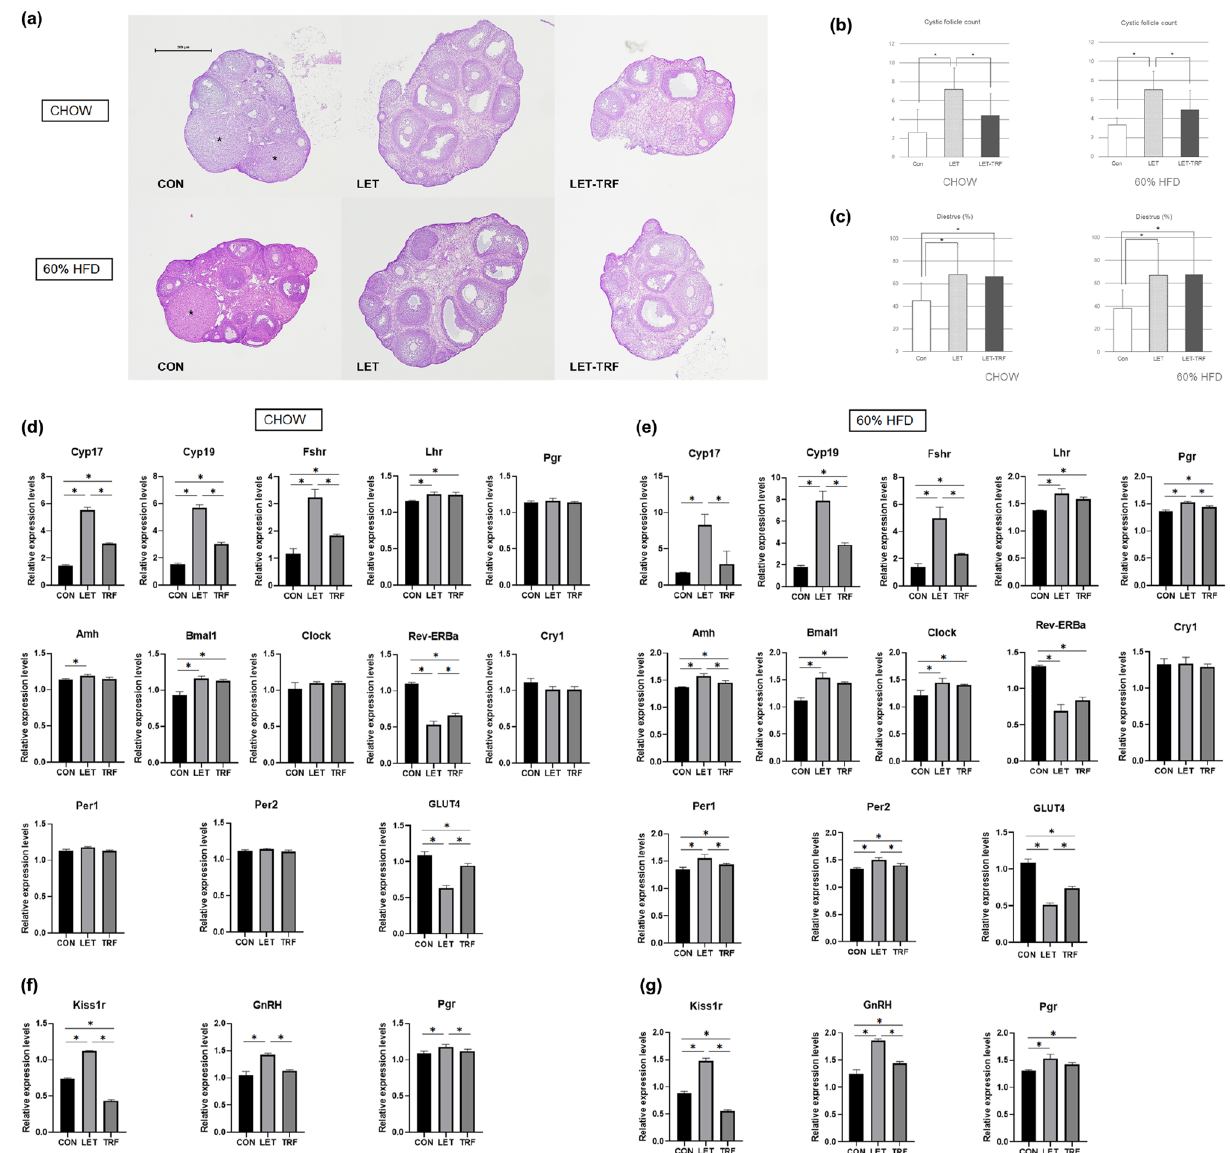
Figure 4. Histological findings of the ovaries, assessment of ovulatory disfunction, and the ovary/hypothalamus expression of key reproductive or circadian rhythm-associated genes. ( a ) Representative images of histological findings of ovaries with H&E staining from CON, LET, and LET-TRF mice according to diet. The ovaries of LET mice showed virtually enlarged and polycystic morphologies compared to those of CON and LET-TRF mice, either in CHOW or 60% HFD. Asterisks indicate the identified corpus luteal cysts. ( b ) Mean analyses of cystic follicle count and ( c ) Percentage of diestrus cycle in CHOW and 60% HFD treatments. ( d ) Mean expression levels of mRNAs in the ovaries from the CHOW diet treatment and ( e ) those from HFD experiment. ( f ) Mean expression levels of mRNAs in the anterior hypothalamus/POA samples from the CHOW diet treatment and ( g ) those from HFD treatment. * P < 0.05. 60% HFD, 60% kcal high-fat diet, TRF time-restricted